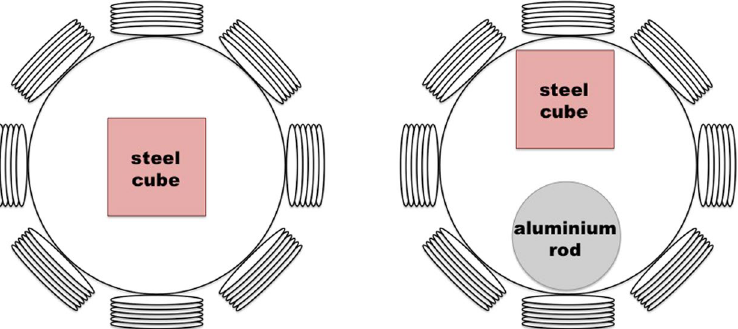
Figure 8. Experimental setup of a steel cube (side length 38.00 mm) positioned in the centre of the imaging region ( A ), and an aluminium tube (D42.00 mm, H44.00 mm) and the same steel tube positioned side by side in the imaging region ( B